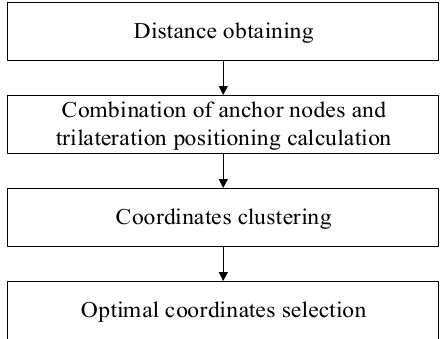
Figure 1. The flowchart of the improved trilateration based on the combination and clustering strat- egy.